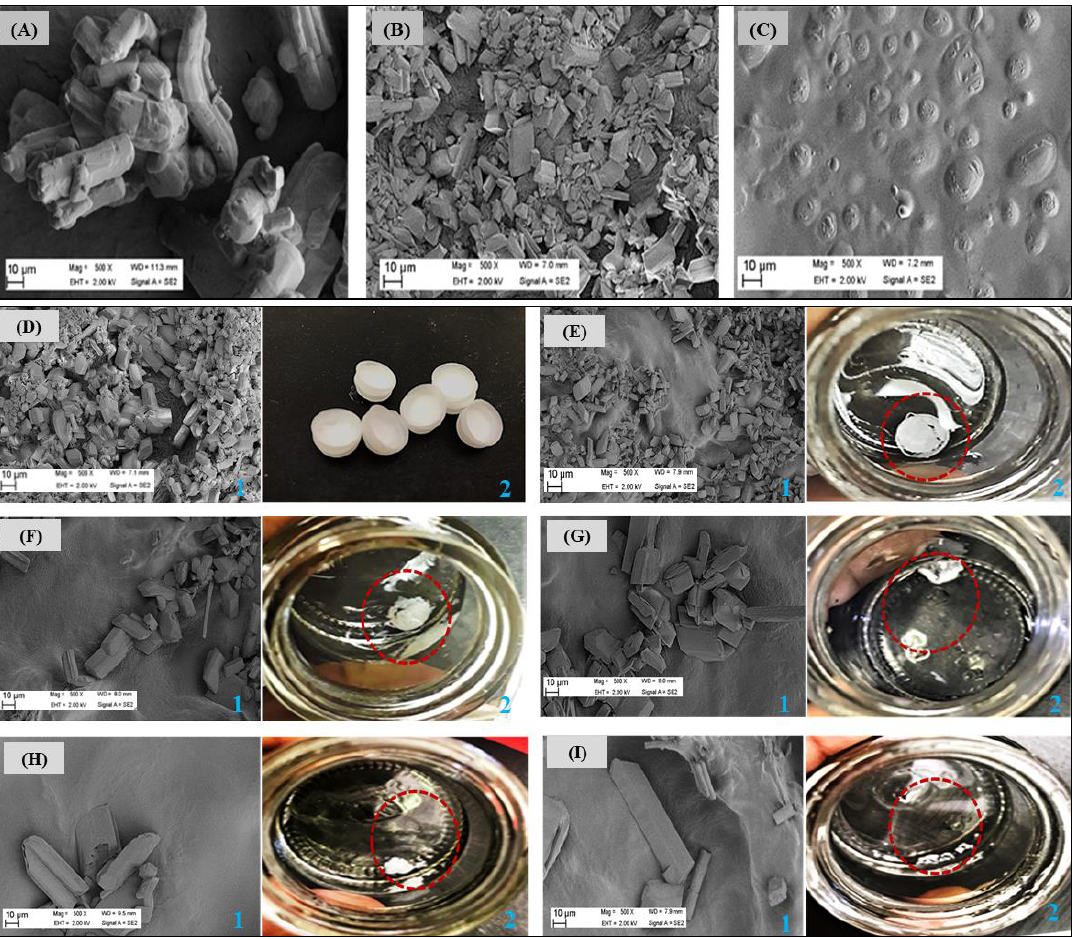
Figure 8. Scanning electron micrographs of ( A ) pure PZA, ( B ) optimized PZA loaded formulation,